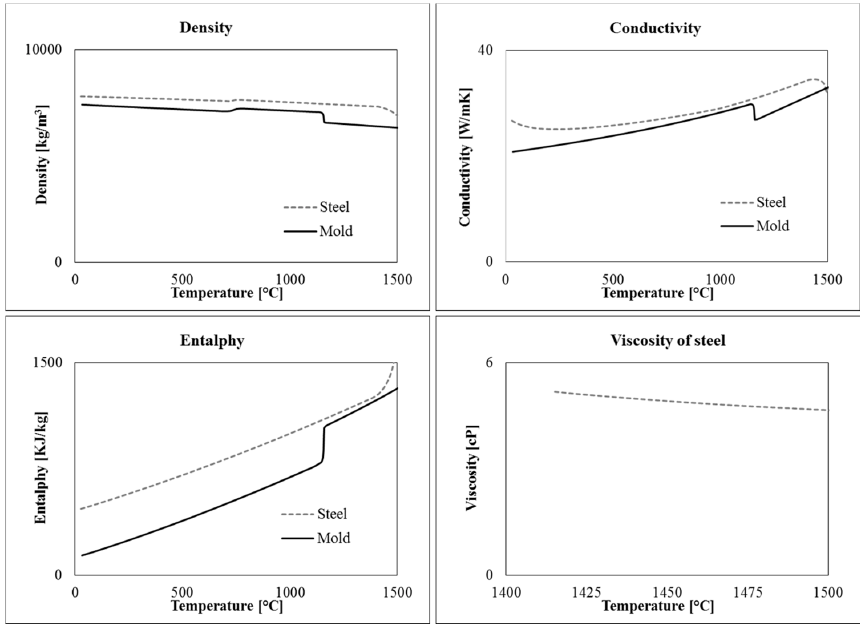
Figure 3. Thermophysical properties of mold and steel as a function of temperature.